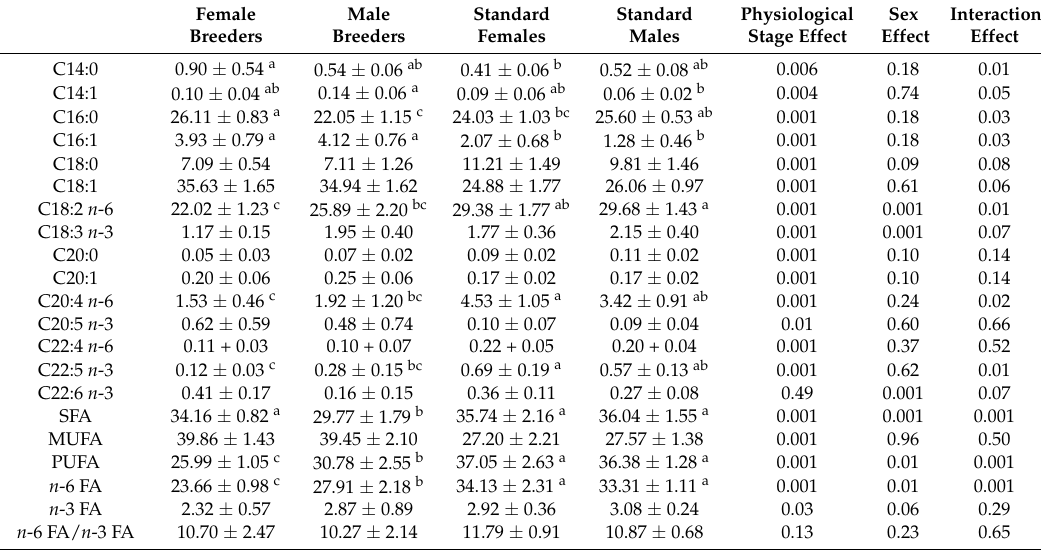
Table 4. Fatty acid (FA) composition of P. major muscle from males and females of breeder and standard turkeys (% total FA; n =